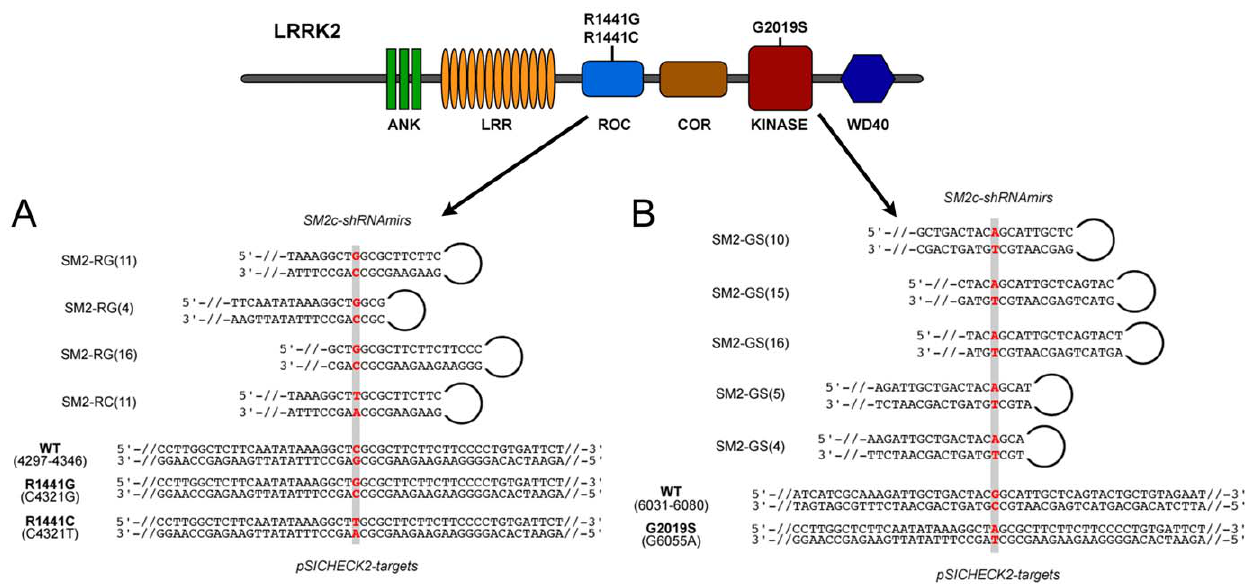
Figure 1. Overview of LRRK2 domains with shRNA and reporter template design. LRRK2 is a large protein (280 kD) composed of multiple domains [51]. Although PD-linked mutations have been described throughout the protein, only mutations addressed in this work that affect the ROC and kinase domains are shown. A. Schematic design of shRNAs to target ROC-associated mutations is shown, illustrating the MRS shifts and the nomenclature used. Numbering is according to 5 9 to 3 9 position in the antisense ‘‘guide’’ strand. The shRNAs were expressed from U6 promoter- based SM2c, and a post-Drosha/pre-Dicer version is depicted. Portions of the WT and mutant LRRK2 target sequences are shown, which were centrally located in a stretch of 400 bp included in the pSICHECK-2 vectors. B. The design of shRNAs and templates to target the G2019S kinase mutation is shown. ANK: Ankyrin-like, LRR: Leucine-rich repeats, ROC: Ras of Complex proteins, COR: C-terminal of ROC, WD40:40 amino acid WD (or beta-transducin)